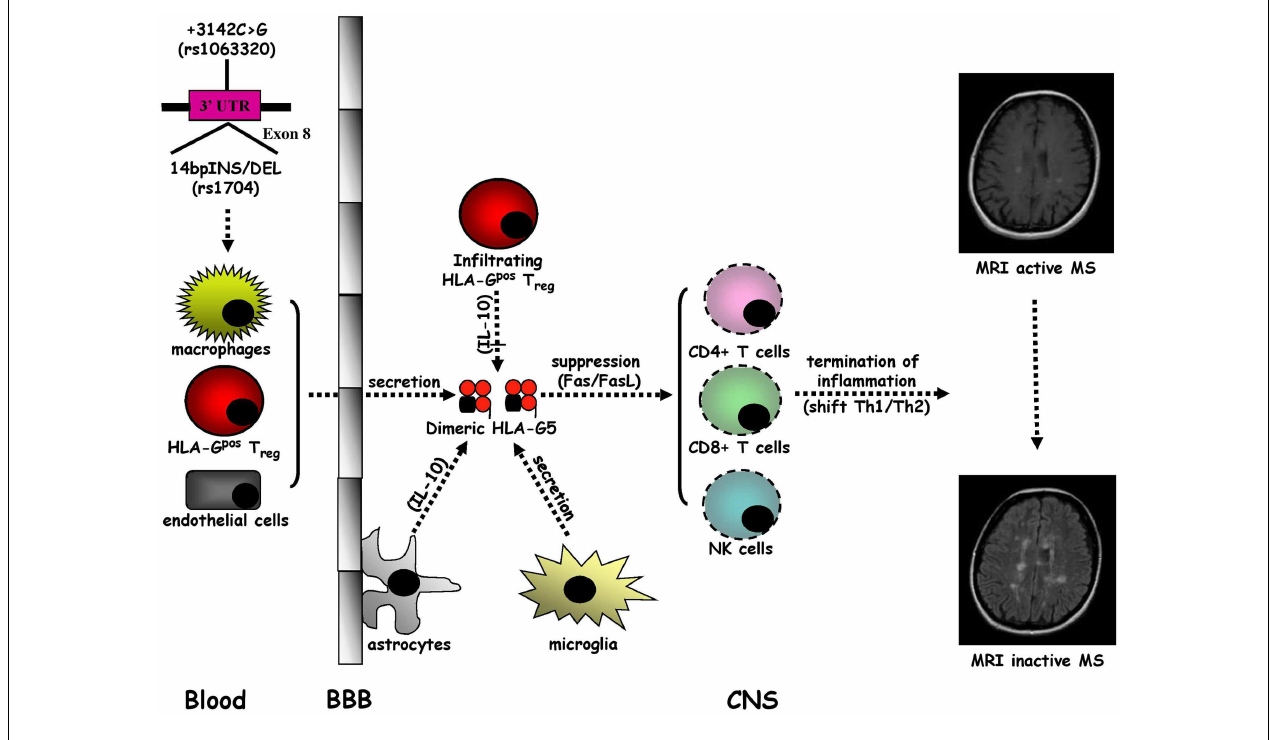
promote the suppression of CD4 + Th1 cell activity and the apoptotic removal of CD8 + T cells and NK cells that favor the formation of an anti-inflammatory intrathecal microenvironment leading to the termination of MS